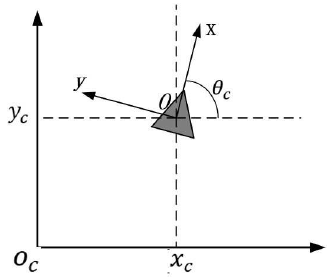
Figure 5. The state of the OMR in Cartesian